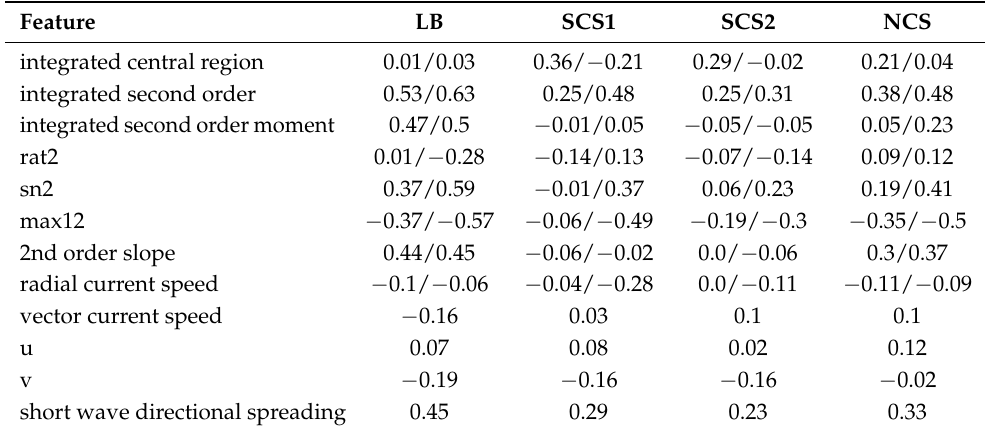
Table 4. Correlation coefficients between Doppler spectra features and metocean parameters labelled R in Table 3 and wind speed for the training data sets. Where two figures are given, the parameters refer to each